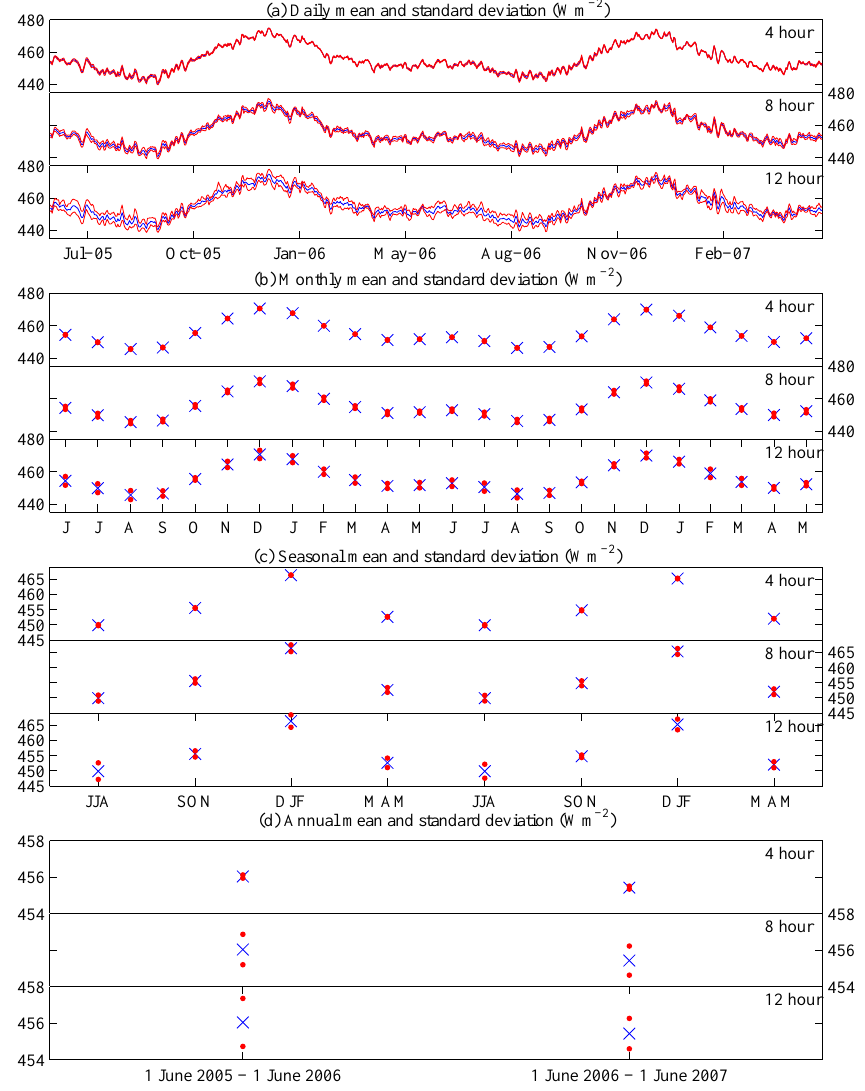
Figure 6. The blue curves/points show t for the ( a ) daily; ( b ) monthly; ( c ) seasonal and ( d ) annual intervals. The red curves/points show t ± σ r , n . Within each panel, the three sub-panels show, from top to bottom, a 4-, 8- and 12-h sampling frequency. The vertical scale is fixed within each set of three